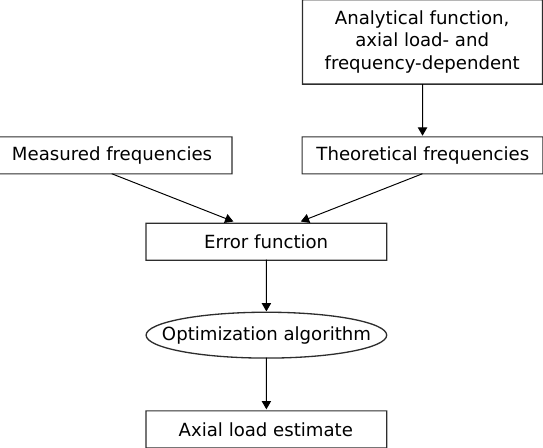
Axial load evaluation from tie-rod natural frequencies: flowchart of the adopted optimization